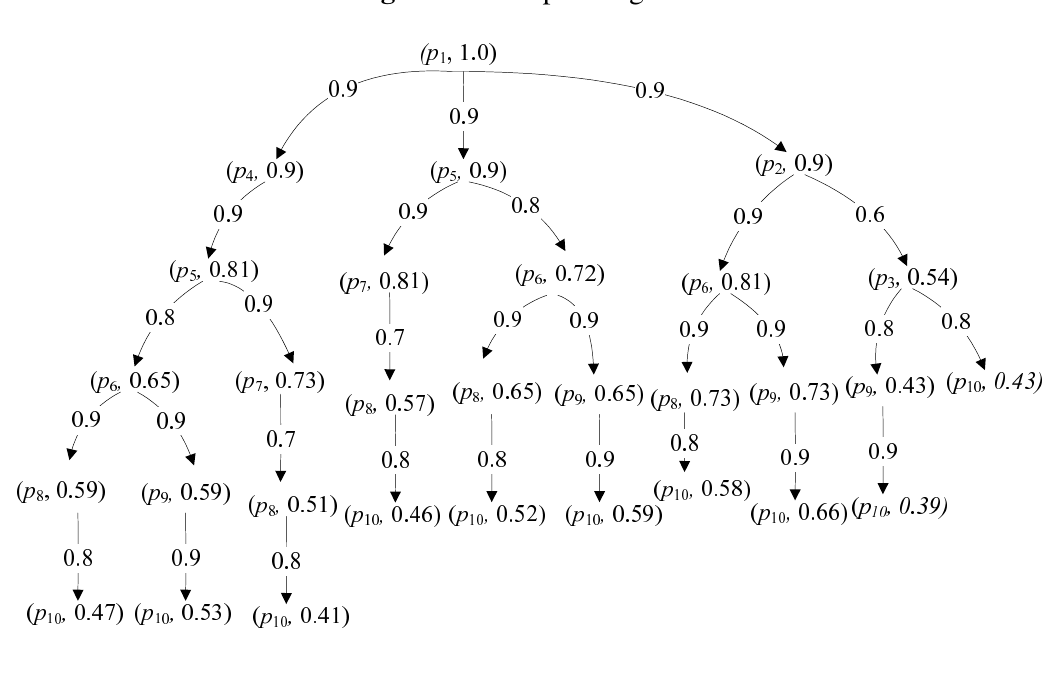
Figure 9. The sprouting